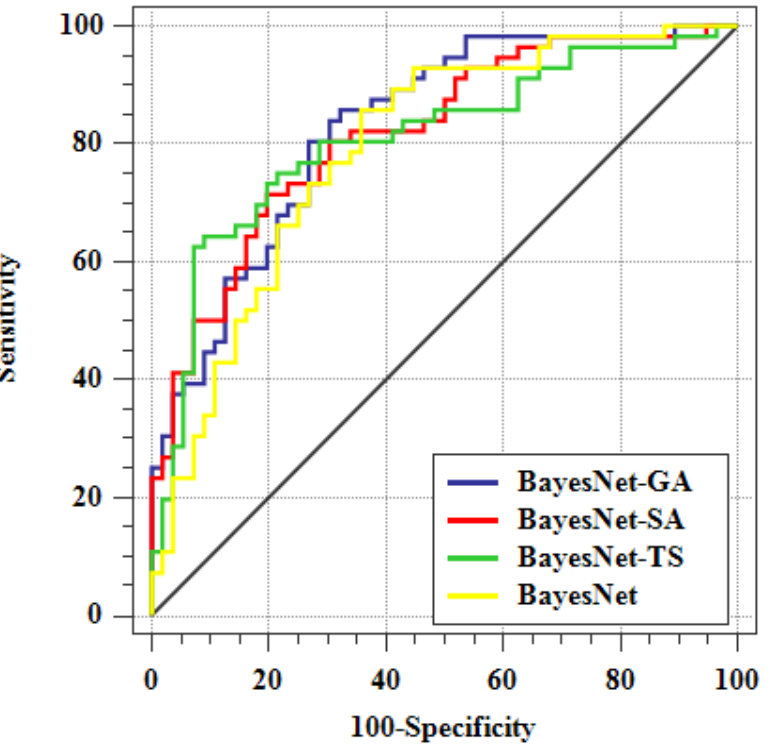
Table 4. Results of the ROC–AUC for the hybrid models.